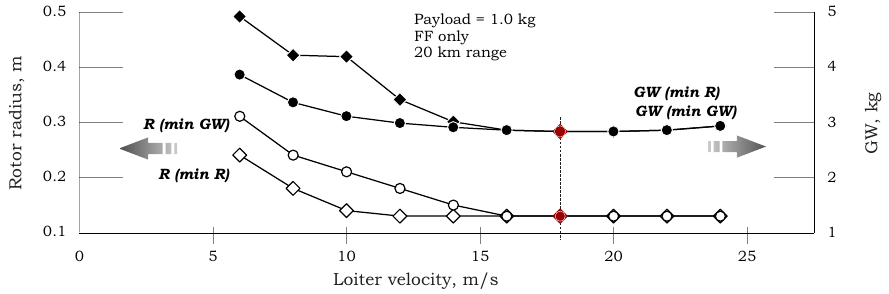
Figure 22. Propellers radii and gross-weights for forward flight only